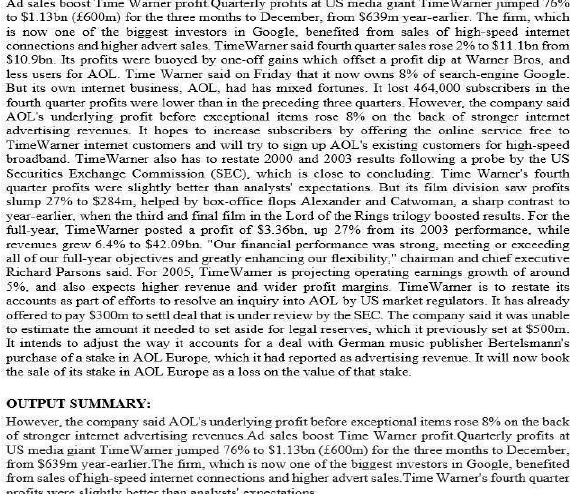
Fig. 2 Output for image input